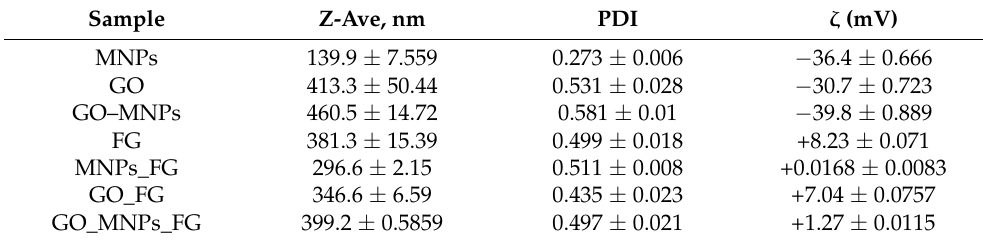
Table 1. The hydrodynamic parameters of each component and precursor